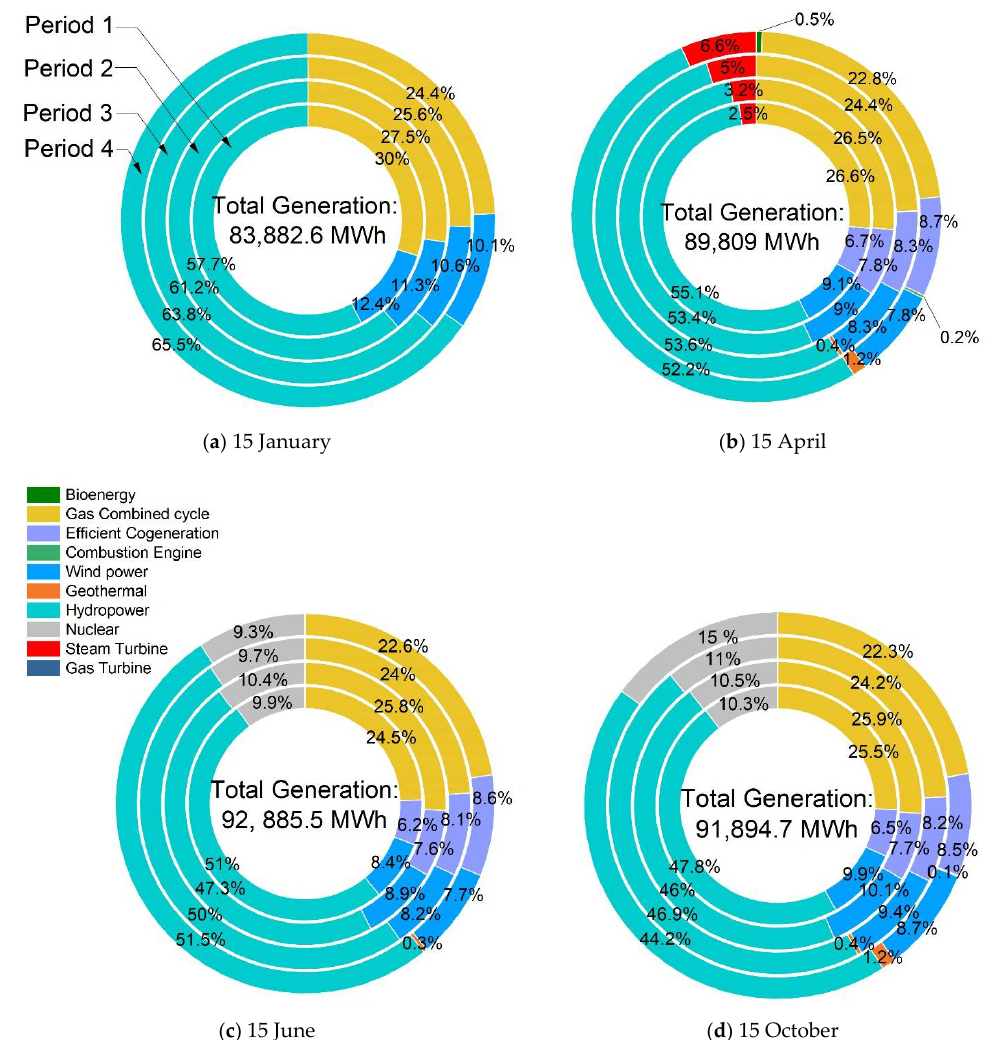
Figure 13. Generation matrix obtained with the model to satisfy the demand of the study area on 4 days of the year. ( a ) Winter representative day (15 January); ( b ) spring representative day (15 April); ( c ) summer representative day (15 June); ( d ) autumn representative day (15 October). Table 4. Electricity generation by period on the four studied seasonal days.